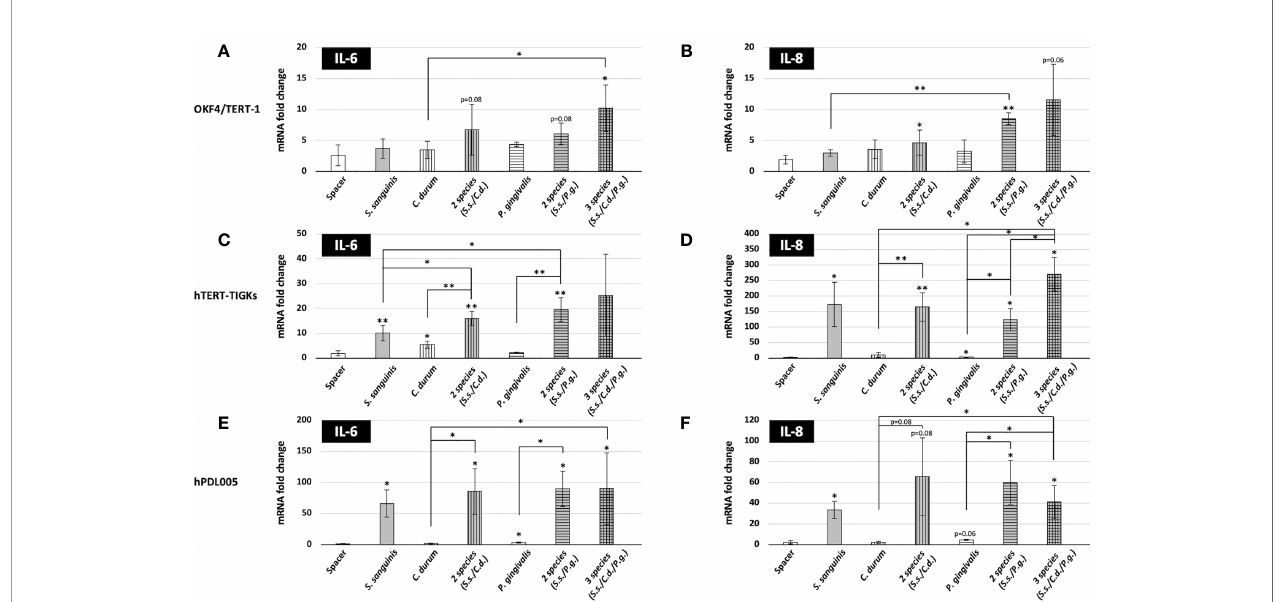
FIGURE 4 | Expression of IL-6 and IL-8 genes in oral mucosal and gingival cells after bio fi lm challenge. Gene expression was assessed after a 6-h challenge with bio fi lms. The coverslips were placed with the bio fi lms facing the eukaryotic cells, but separated by the spacer as shown in Figure 1 and then incubated at 37 °C with 5% CO 2 . After bio fi lm challenge, host cells were removed, RNA was isolated, and the expression of IL-6 and IL-8 genes was determined by qRT-PCR. Data represent the averages and standard deviations of at least 3 biological replicates. (A, B) OKF4/TERT-1; (C, D) hTERT-TIGKS; (E, F) hPDL005. (p-value indicated) * P ≤ 0.05; ** P ≤